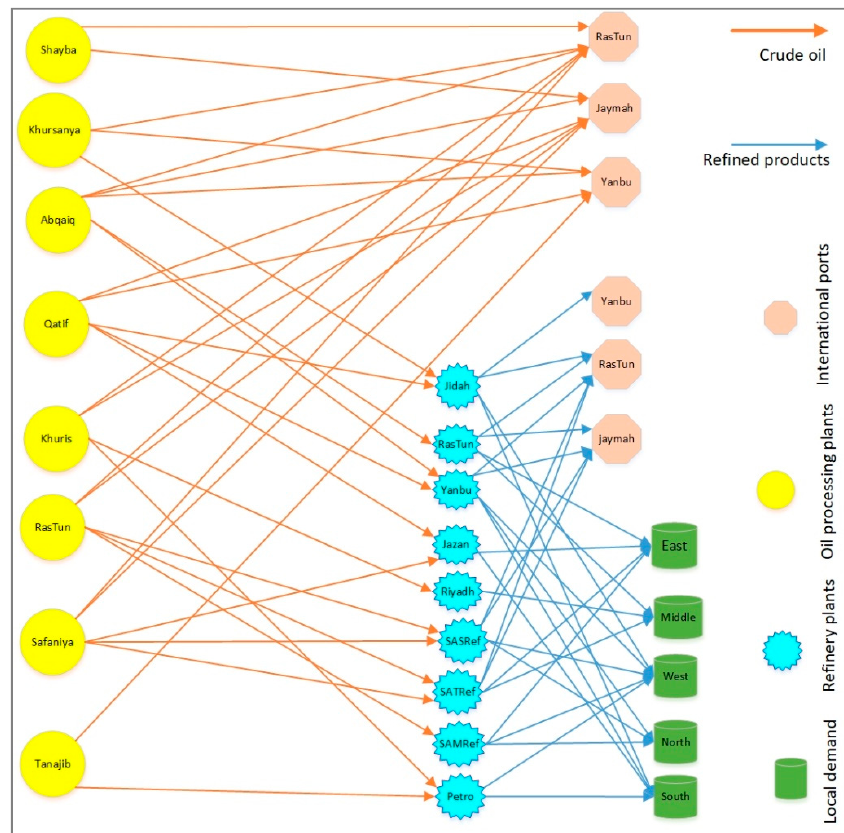
Figure 2. The oil network.